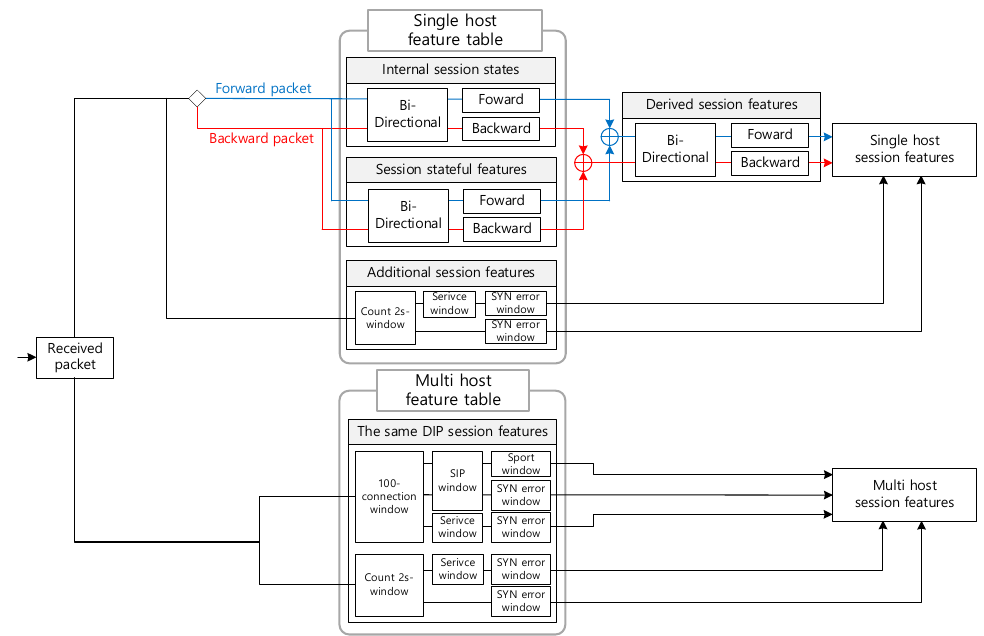
Figure 3. Block diagram for incremental generating integrated features from data traffic.